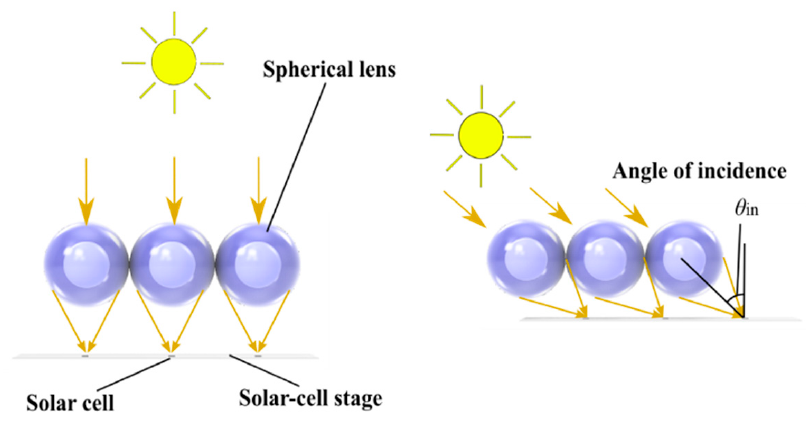
Figure 1. Tracking motion of the spherical-lens microtracking concentrator photovoltaic (CPV) (SMTCPV).